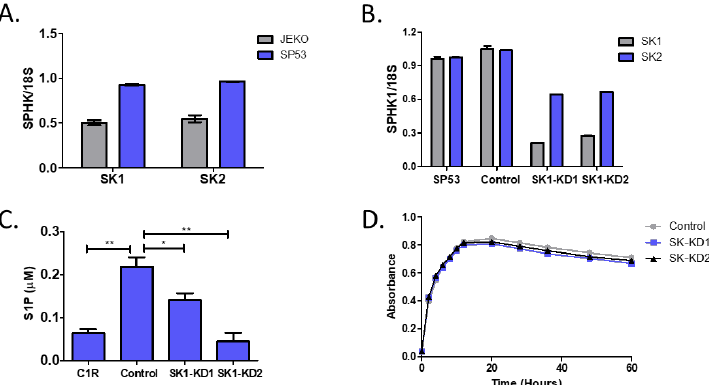
Figure 3. Generation of sphingosine kinase knockdown cell lines. ( A ) mRNA levels of SK1 and SK2 in Jeko and SP53 MCL lines were normalized to 18S expression. ( B ) SP53 cells were stably transfected with shRNA plasmids to knock down expression of sphingosine kinase 1 (SK1) or with a scrambled shRNA control plasmid. Two clones were selected and used for experiments (SK1-KD1 or SK1-KD2). Knockdown of SK was confirmed by quantitative real-time PCR (qPCR). SK1 and SK2 levels were assessed relative to 18S. Expression in the parental cell line (SP53) was compared to the scrambled shRNA control and the SK1-KD clones. ( C ) Reduction of SK results in decreased S1P production. S1P levels in cell lysates were measured by ELISA. ( D ) Control (SP53), SK-KD1, and SK-KD2 cell growth was monitored by WST-1 using absorbance at 440 nm. Error bars are contained within the points. Data was analyzed by a two-tailed t-test. * p < 0.05; ** p < 0.001.